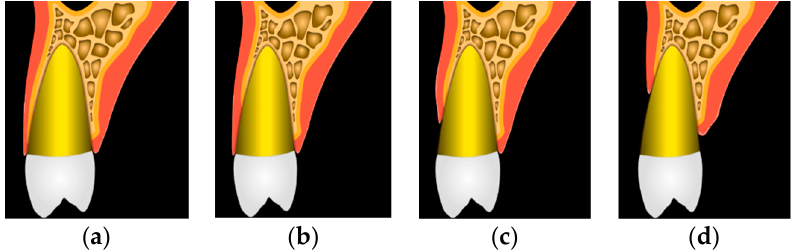
Figure 1 . Chang’s classification of extraction sockets is based primarily on the extent of destruction to the walls: ( a ) Class I: intact soft tissue walls and hard tissue walls; ( b ) Class II: intact soft tissue wall, but the destruction of at least one bone wall in the socket; ( c ) Class III: recession of all soft tissue walls by ≤ 5 mm; and ( d ) Class IV defect: soft tissue recession > 5mm (figures provided by Dr. Fred